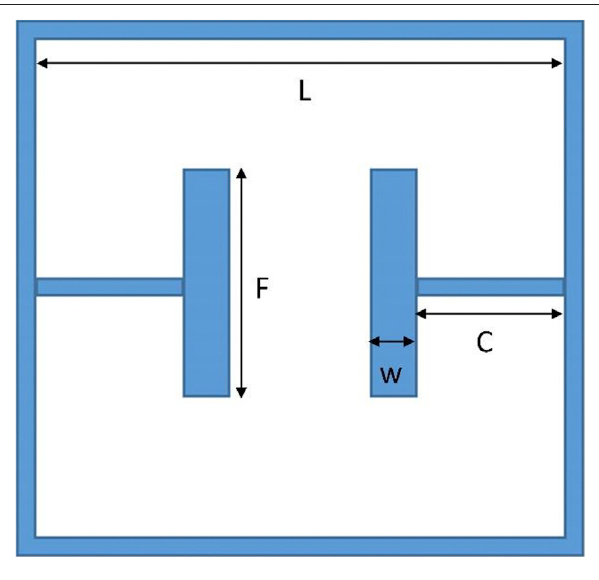
FIGURE 11 | Schematic of the